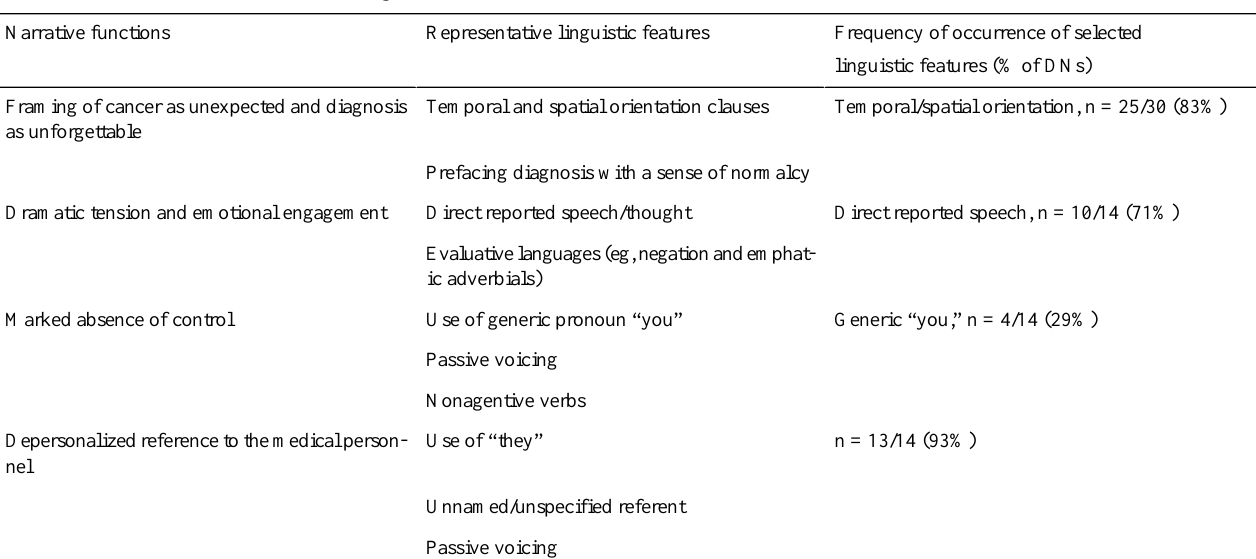
Table 2. Common discursive elements in diagnostic narratives (DNs)